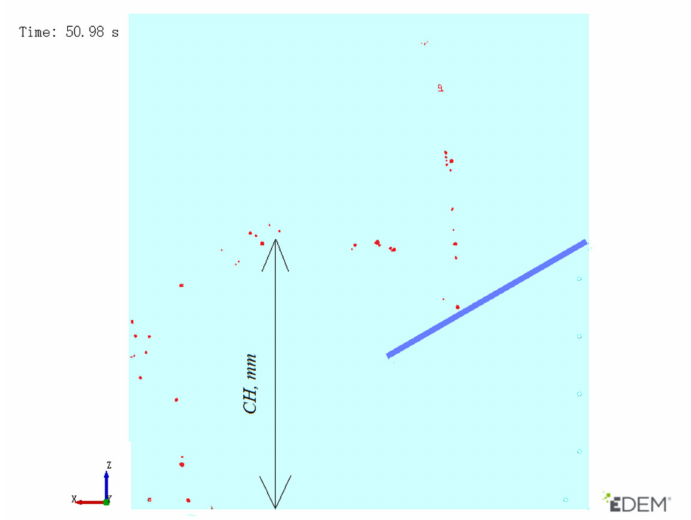
Figure 10. Measurement of the highest collision heights of the collided granular fertilizers of the discharge-drop